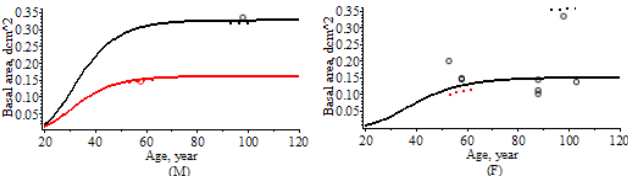
Figure 5. Dynamics of the mean tree basal area at different ages. ( M ) Mixed-effects scenario for two stands; ( F ) fixed-effects scenario for all stands; solid line—mean tree basal area curve determined by using the marginal probability density function; dotted line—mean tree basal area determined by using the conditional probability density function where the height is equal to the mean height of the stand; black in ( M )—the first stand; red in ( M and F )—the second stand.